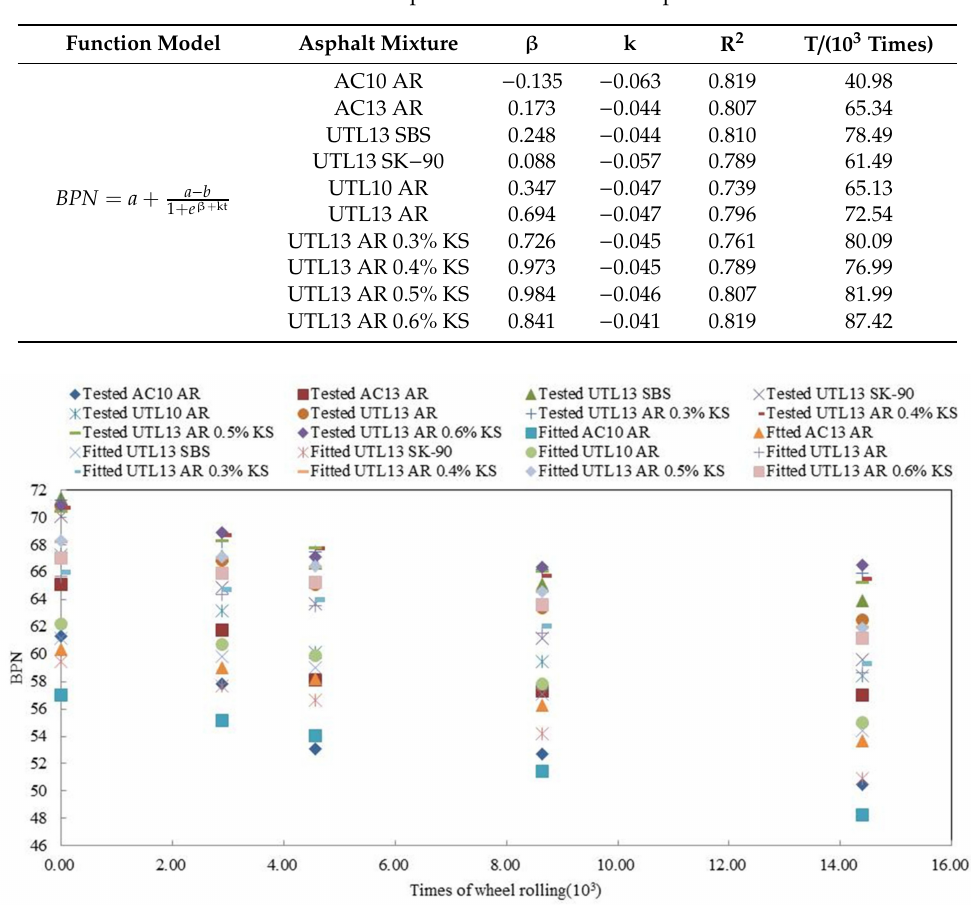
Table 8. The BPN model parameters of di ff erent asphalt mixtures.